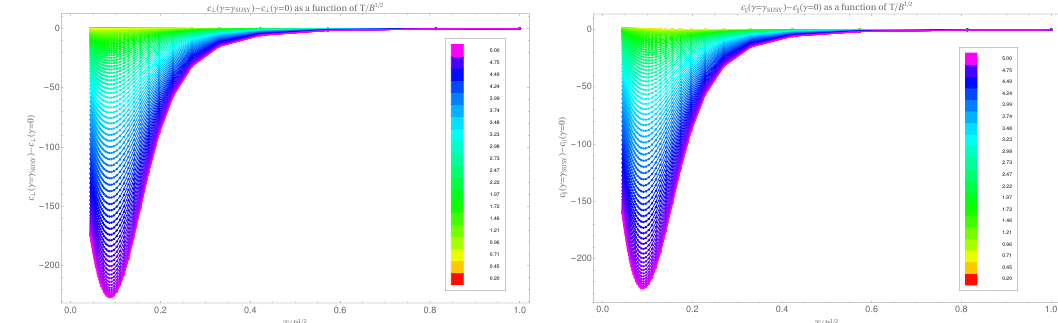
Figure 18 . We display the difference between the c-functions, ∆ c as computed with and without Chern-Simons coupling. Left: ∆ c ⊥ . Right: ∆ c . In both images these are displayed as a function || of dimensionless Temperature T/B 1 / 2 at fixed µ/T = 5 for ‘ varying from ‘ = 2 / 10 to ‘ = 5